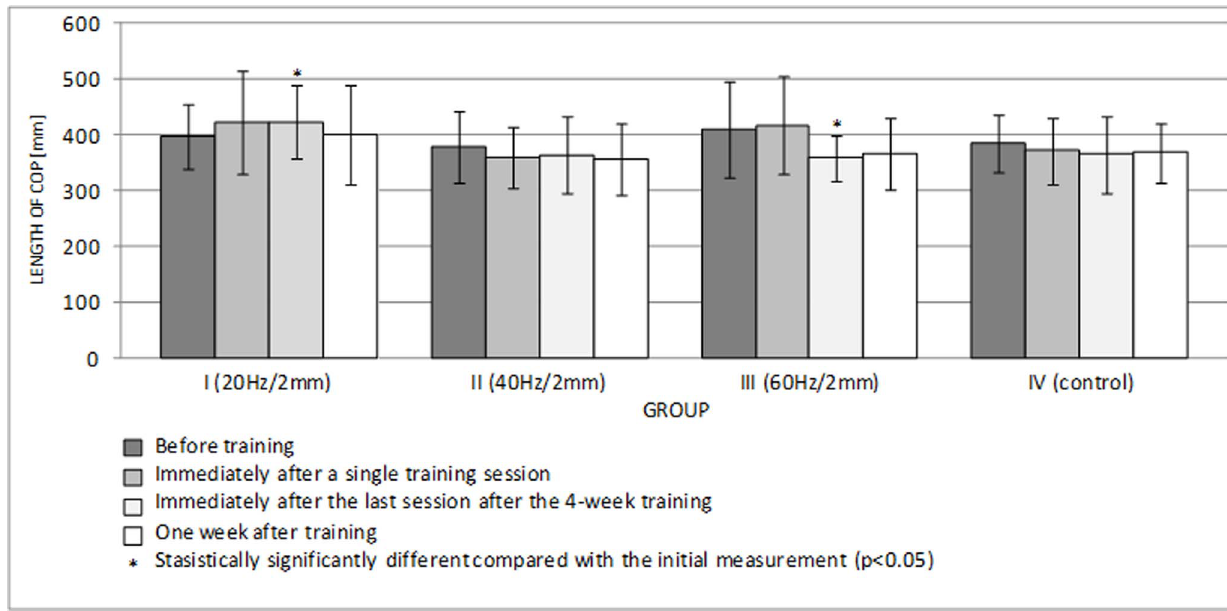
Figure 4. Length of COP in the AP plane (mean ± standard deviation) (mm) after training.